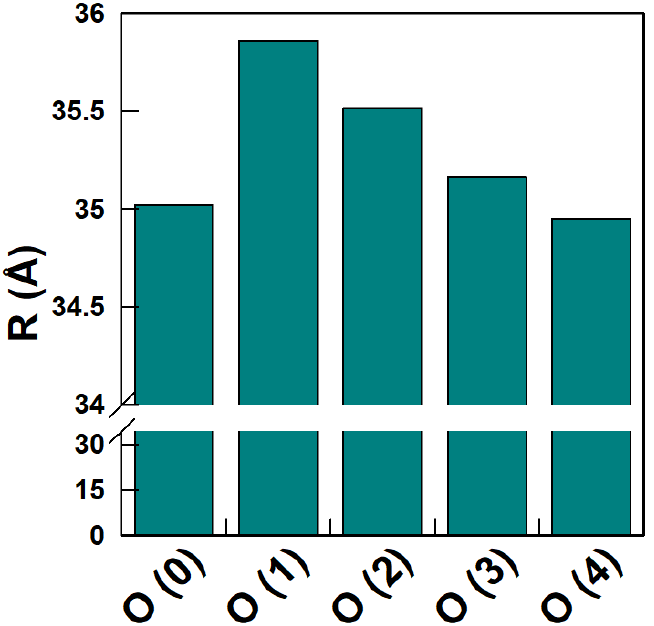
Figure 6. Average distances (Å) between the oxygens of GA molecule and the COM of the nanoemulsion.